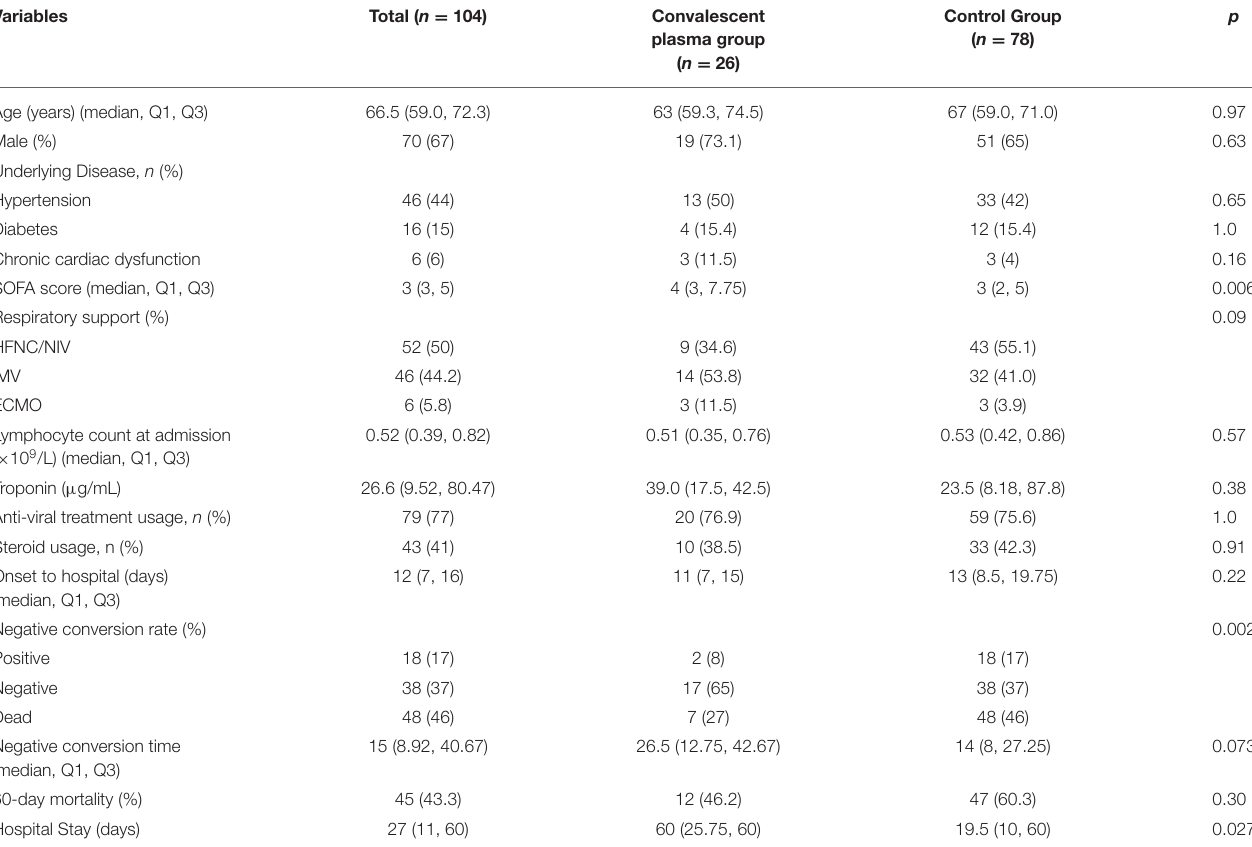
TABLE 1 | Characteristics of patients with coronavirus disease 2019 (COVID-19). Variables Total ( n = 104) Convalescent